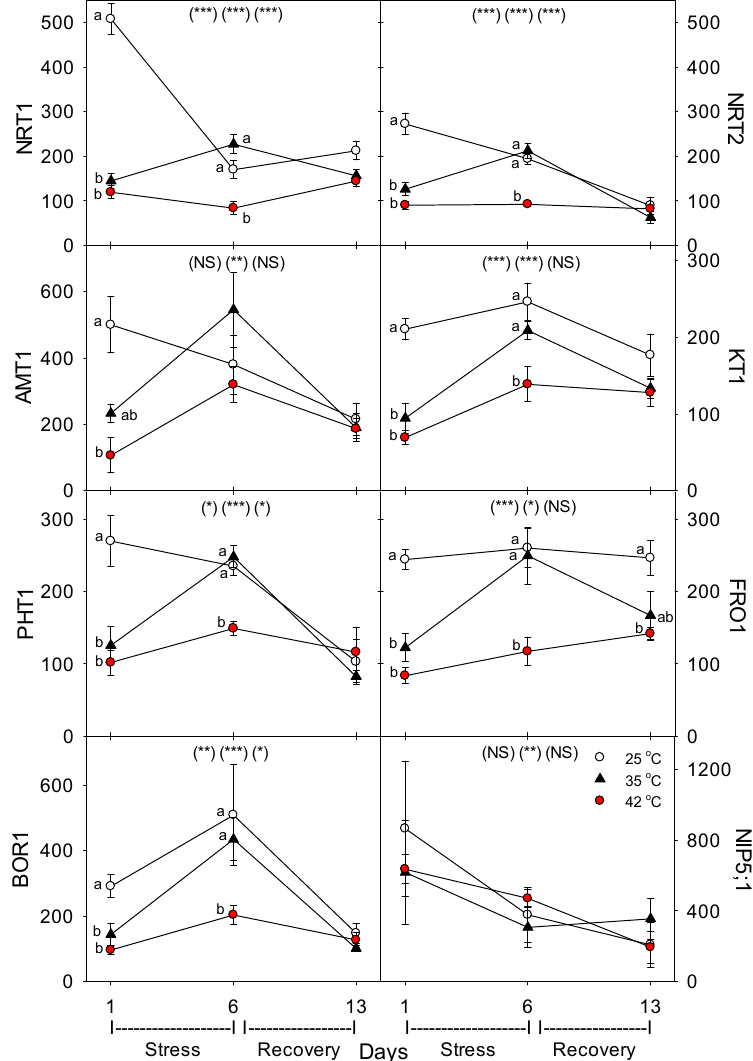
Figure 6. Effect of abrupt heat stress on relative levels of specific nutrient transport proteins (per g dry root) in roots of tomato: low-affinity NO 3 , NRT1; high-affinity NO 3 , NRT2; NH 4 , AMT1; K, KT1; P, PHT1; Fe, FRO1; B, BOR1 and NIP5;1. Plants were grown at 25 °C/20 °C day/night (control), and then subsets of plants were heat stressed at 35 °C/30 °C or 42 °C/37 °C day/night for one or six days (maximum root temperatures = 32 °C or 39 °C), and then returned to control conditions for seven days of recovery (=day 13). Values are means ± 1 SE for four independent replicates from each harvest (days 1, 6, 13). Statistics are as in Figure 1. * p < 0.05, ** p < 0.01, *** p < 0.001.